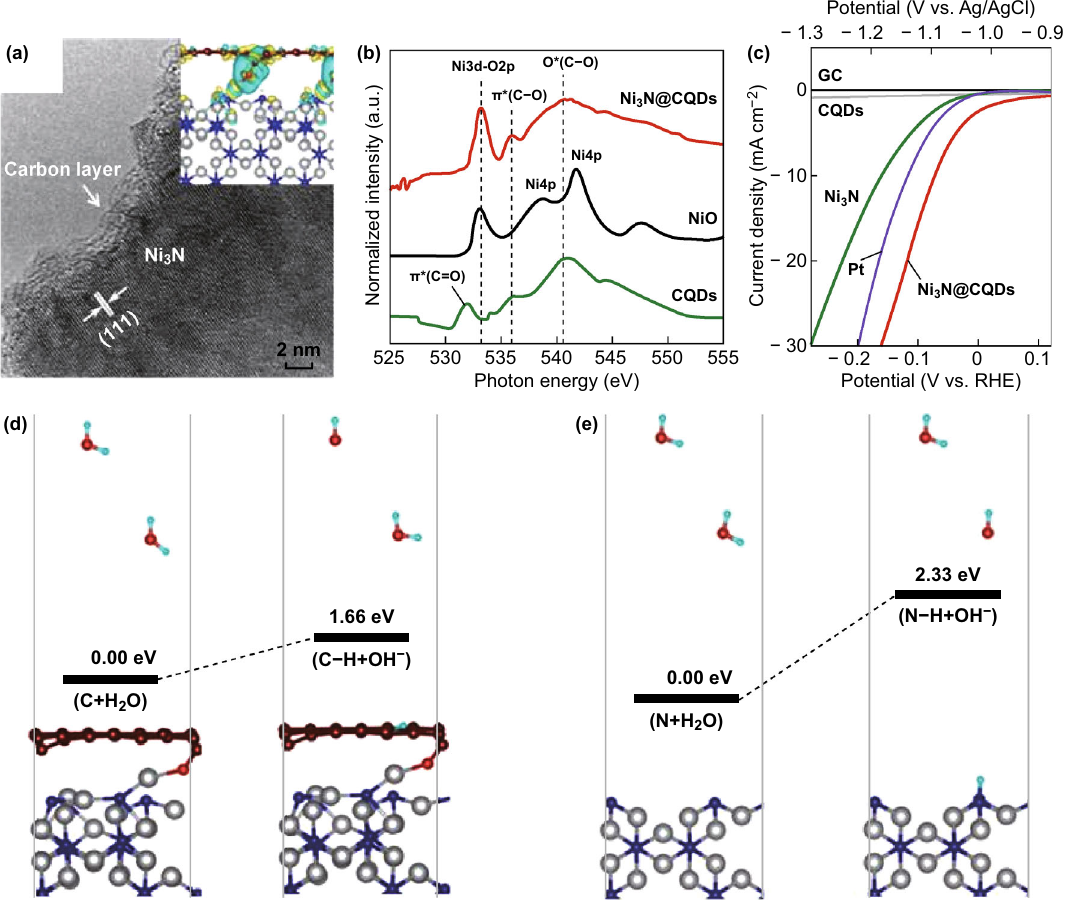
Fig. 6 a High-resolution TEM (HRTEM) image of Ni 3 N@CQDs, b O K-edge X-ray absorption near-edge structure (XANES) spectra of Ni 3 N@CQDs, commercial NiO and the CQDs treated in NH 3 at 370 (cid:3) C, c linear scan voltammetry (LSV) polarization curves of Ni 3 N@CQDs in comparison with those of platinum (Pt) electrode, pristine Ni 3 N, CQDs, and glassy carbon (GC) electrode in a 1 M KOH aqueous solution. Comparison of HER Volmer reaction step and the resultant binding energies on carbon-coated Ni 3 N(110) d and pristine Ni 3 N(110) e surfaces. N, Ni, C, O, and H atoms are indicated by blue, gray, brown, red, and cyan, respectively. Reproduced with permission of the authors of Ref.